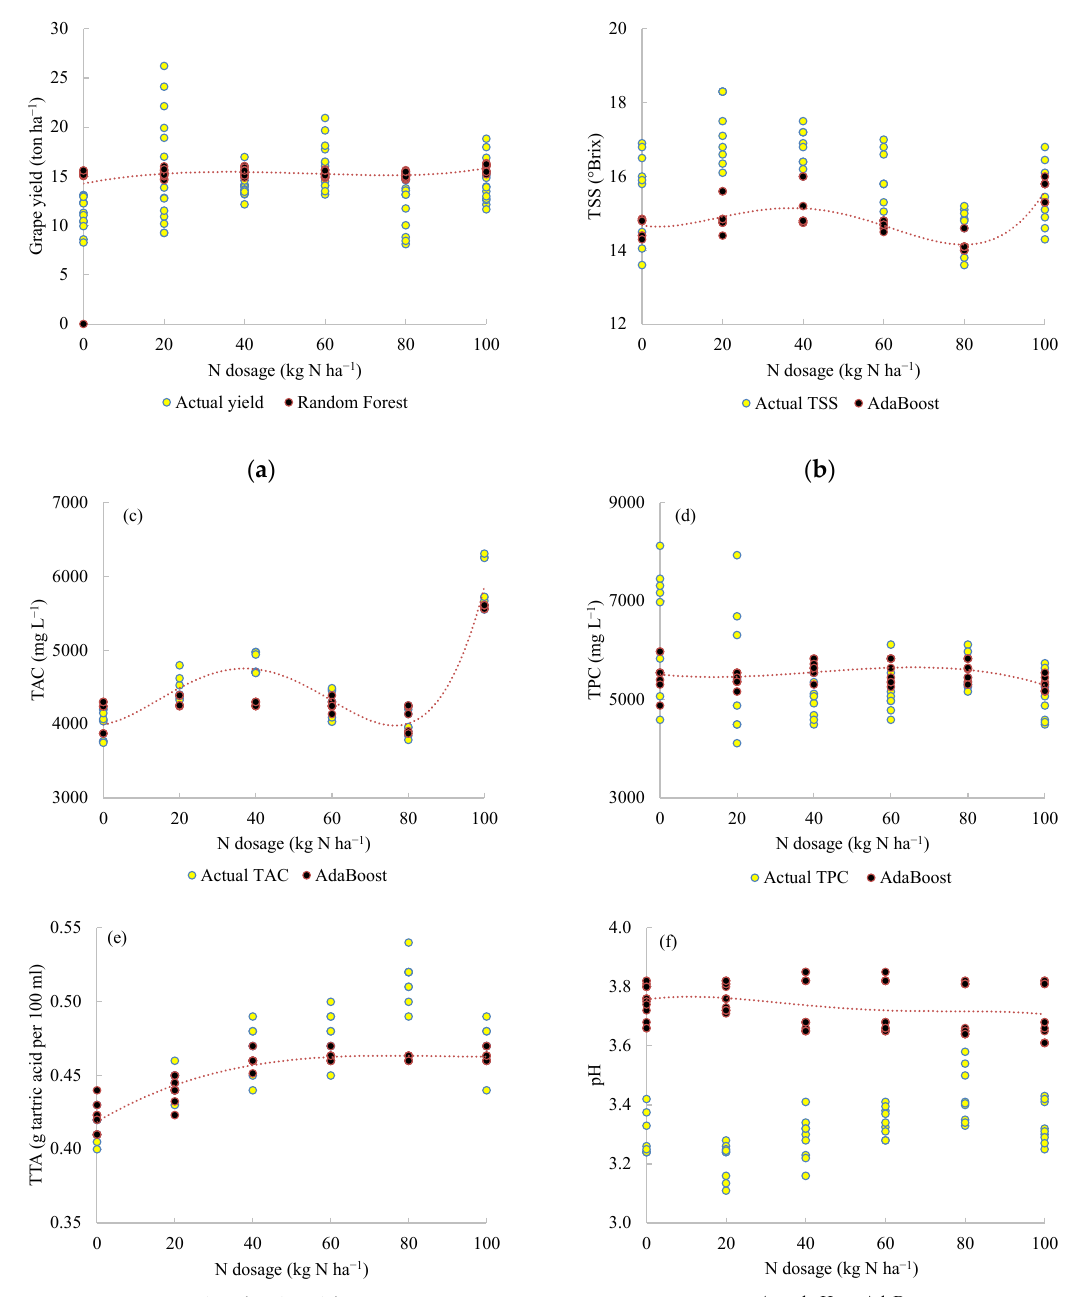
Figure 1. Prediction of the yield ( a ), total soluble solids (TSS) ( b ), total anthocyanin concentration (TAC) ( c ), total polyphenol concentration (TPC) ( d ), total acidity concentration (TTA) ( e ), and pH ( f ) of ‘Alicante Bouschet’ in 2019 for the model calibration for the 2015–2018 period.